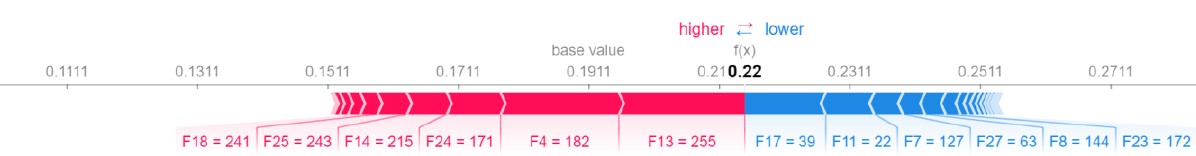
Figure 11. Combined effect of features on model output.